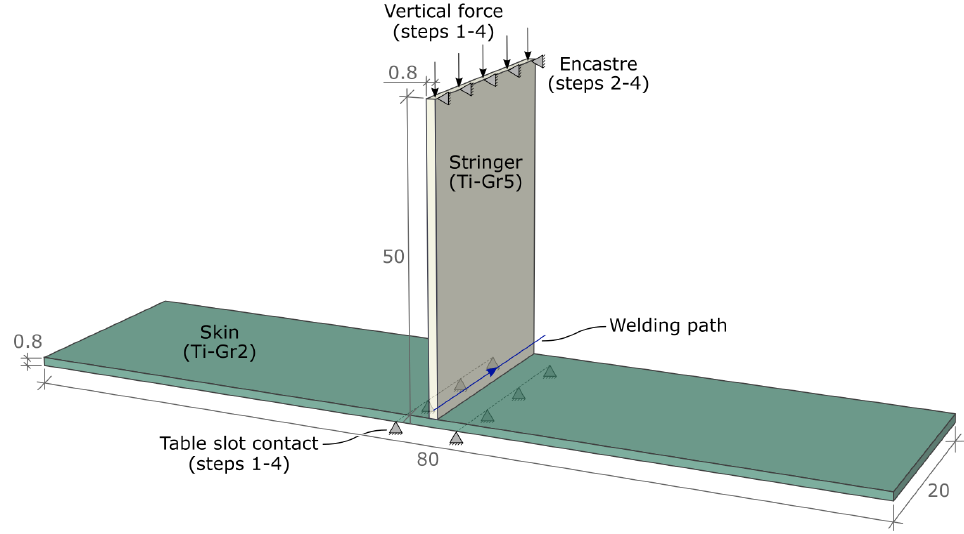
Figure 7. FEM-model dimensions in mm and boundary conditions.